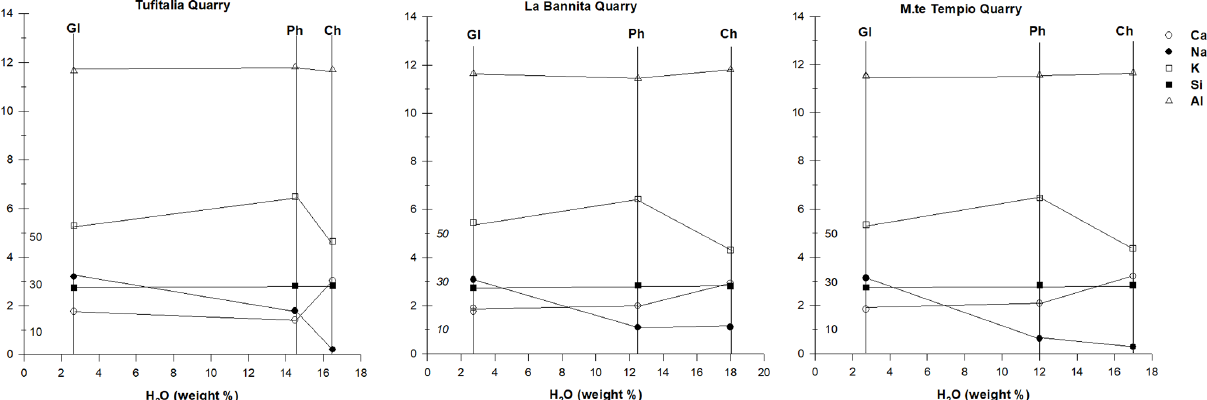
Figure 8. Si, Al, Na, K, and Ca variations during the zeolitization process in samples from Tufitalia quarry, La Bannita Quarry, and Mt Tempio Quarry. Water weight percentage is reported as an abscissa and half of Barth’s anhydrous standard cell content as ordinates (Barth, 1952). For Si a compressed scale is used. GL: glass; CH: chabazite; PH: